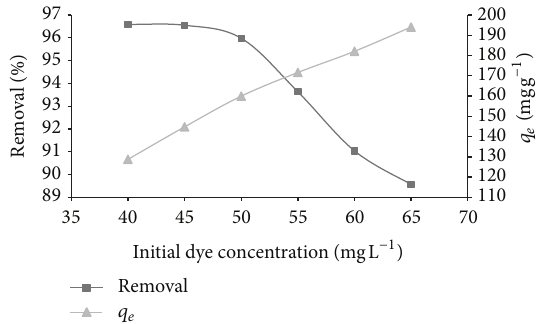
Figure 5: Effect of agitation speed (pH = 4 , adsorbent dose = 0.3